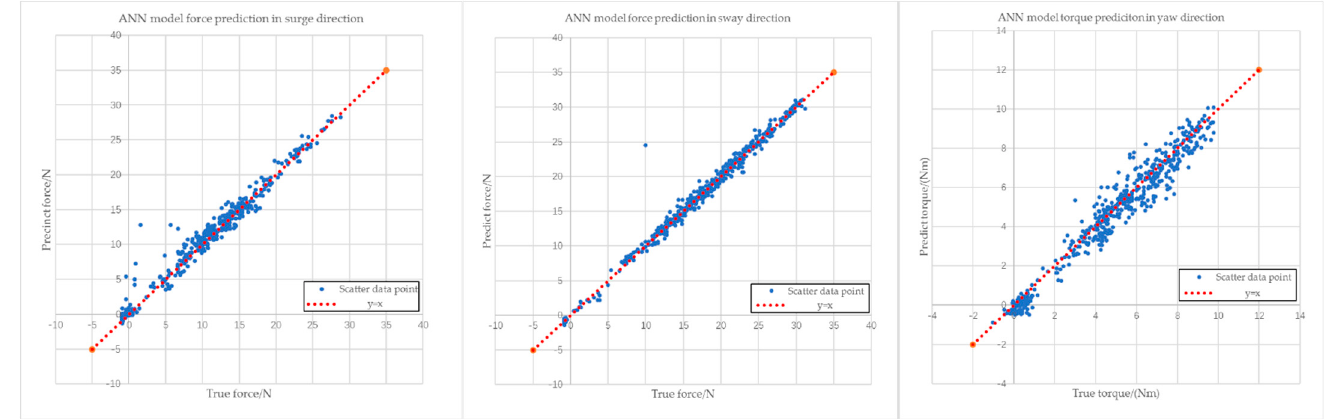
Figure 11. The ANN models predicting scatter images in surge, sway and yaw directions. Table 3. Predicting error of artificial neural network.